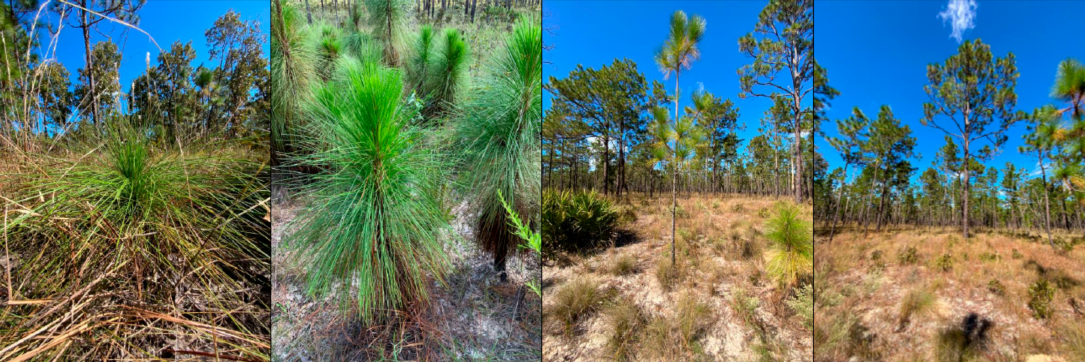
Figure 1. Four distinct life stages of longleaf pine: grass stage, bolt stage, sapling, and tree (left to right). Photo Credit: L.